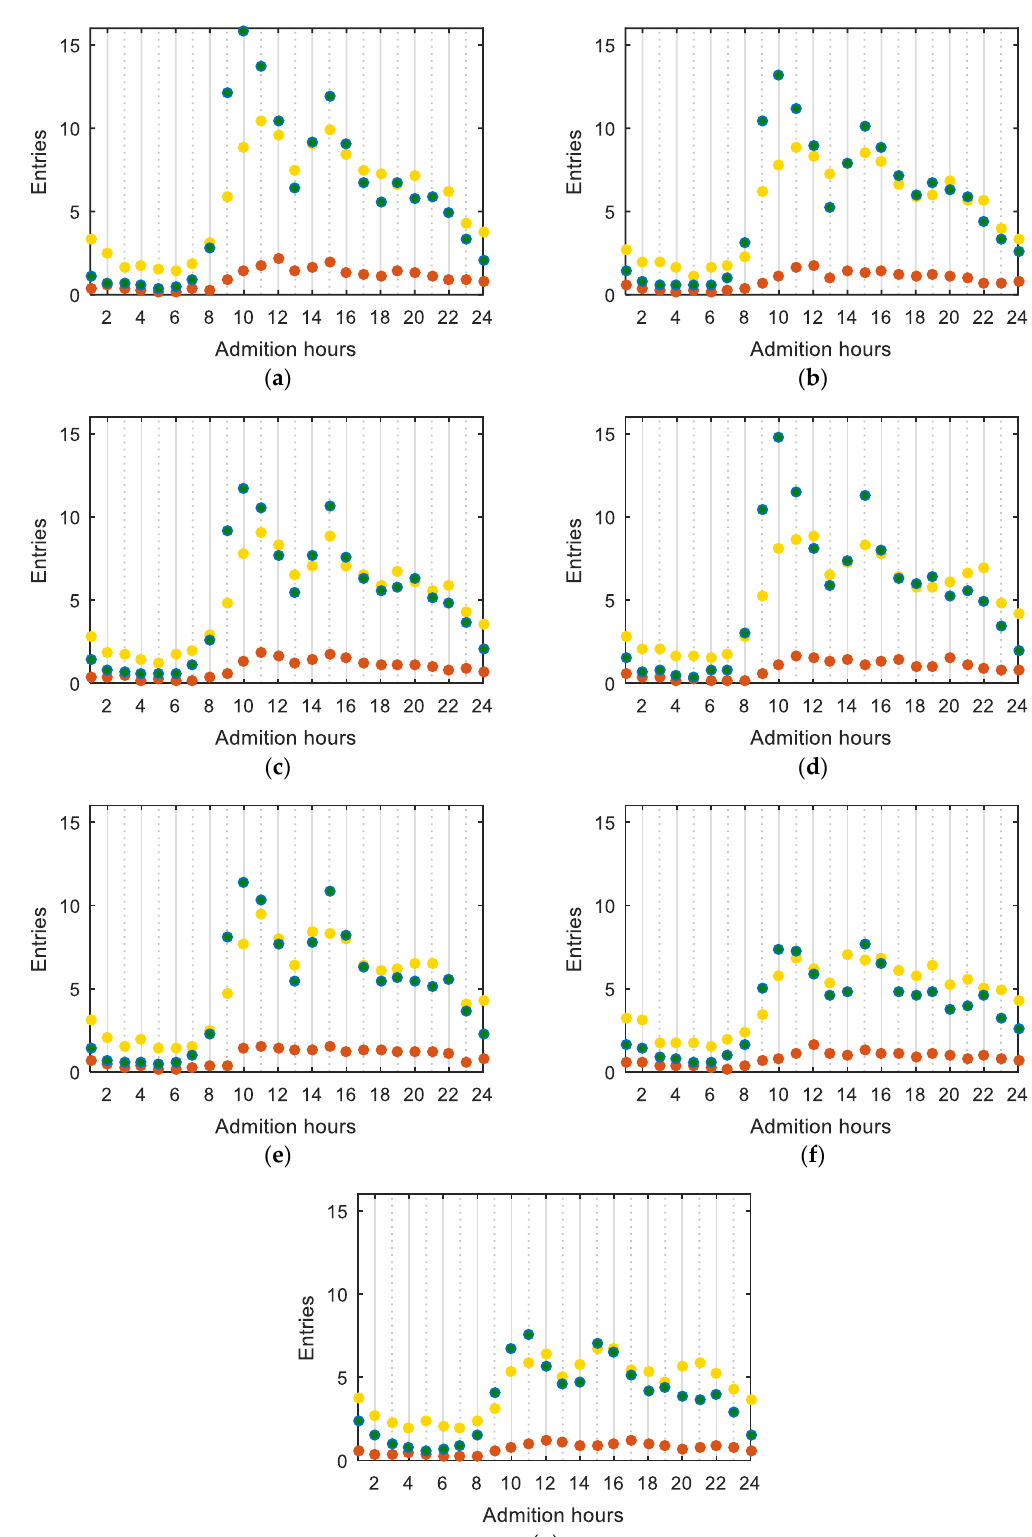
Figure 6. Average arrival rates for every hour per priority for: ( a ) Monday; ( b ) Tuesday; ( c ) Wednesday; ( d ) Thursday; ( e ) Friday; ( f ) Saturday; ( g ) Sunday.